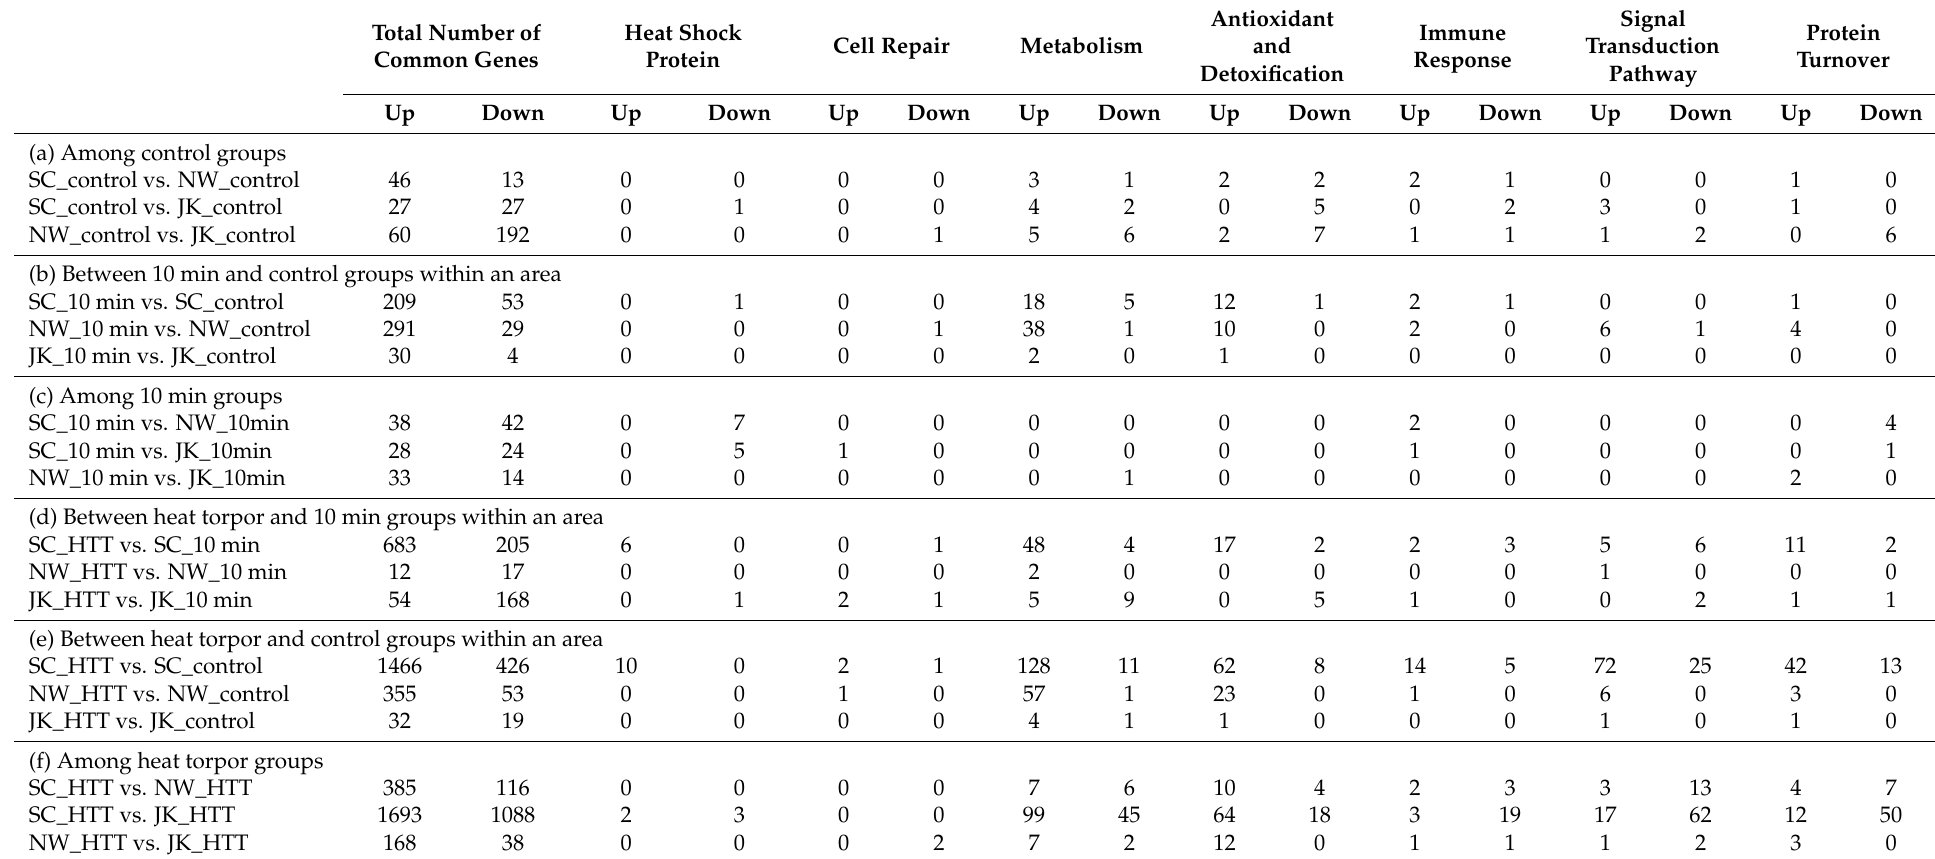
Table 1. Number of differently expressed genes summarized for all transcriptome data and categorized into seven biological functions. Seocho (SC), Nowon (NW), and Jookyo (JK) indicate the high-UHI, low-UHI, and surrounding areas, respectively.